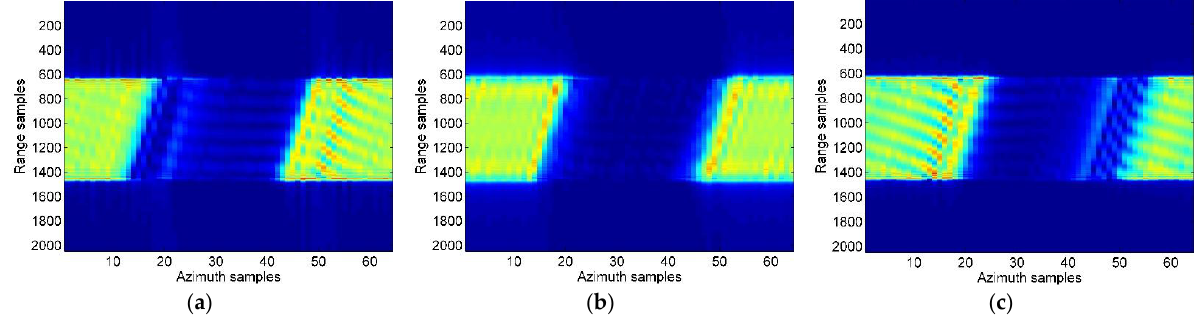
Figure 7. The first sub-aperture two-dimensional wavenumber spectrum of three point targets; ( a ) P 4 , ( b ) P 5 , ( c ) P 6 .